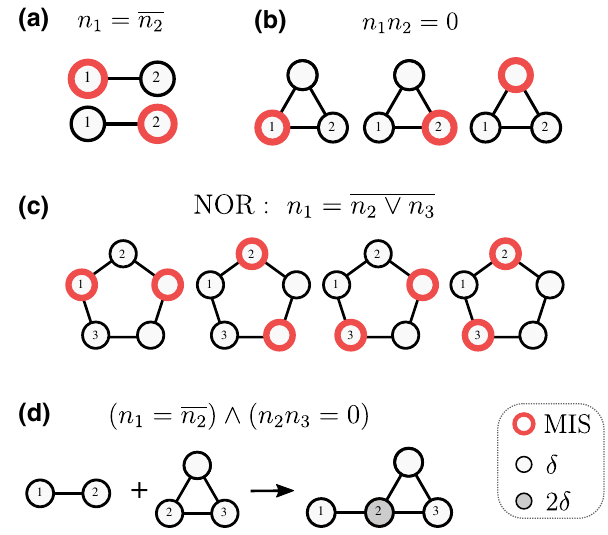
FIG. 3. MWIS representation of some example constraints. Each bit is represented by a corresponding vertex in the MWIS problem graph. The weight of the vertices is indicated by its interior color on a gray scale. For each example, the degener- ate MWIS configurations are shown by identifying vertices in a MWIS with a red boundary. The MWISs correspond to the sat- isfying assignments to the corresponding constraint-satisfaction problem. (a) MWIS representation of n 1 = n 2 . (b) MWIS repre- sentation of n 1 n 2 = 0, with the third, unlabeled vertex being an ancillary vertex. For each of the three MWIS states, the configu- ration on the relevant vertices 1 and 2 matches the corresponding satisfying assignment. (c) MWIS representation of the NOR con- straint using two ancilla vertices. Note that only four of the five MWIS states are shown. Nevertheless, all five MWIS states correspond to the four satisfying assignments on the relevant ver- tices 1, 2, and 3. (d) A set of constraints C = { n 1 = n 2 , n 2 n 3 = 0 } , where each is of the form given in (a),(b). The corresponding MWIS problem is obtained by combining the two graphs cor- responding to both constraints in C , resulting in the weighted graph on the right. Observe that vertex 2, which appears in both constraints, has twice the weight of the other